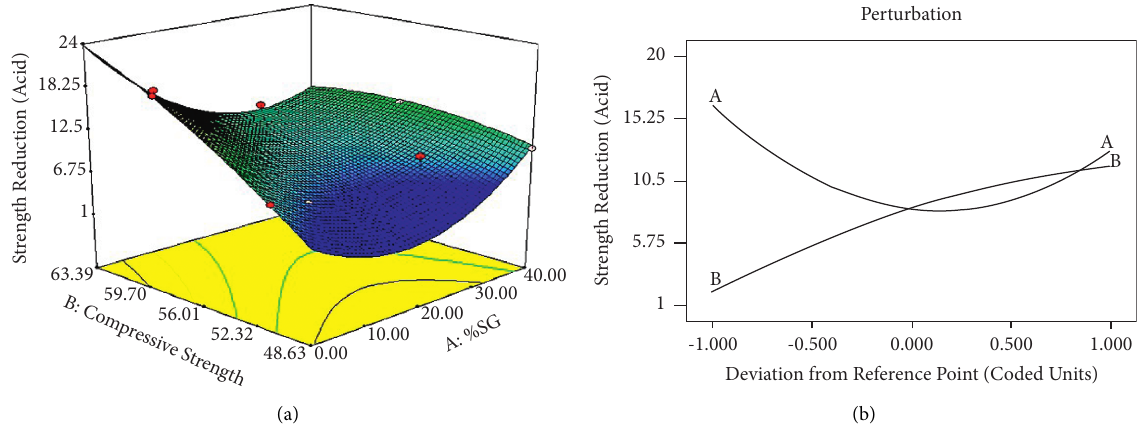
Figure 26: Response surface plots (a) and perturbation plots (b) indicating the relationship between spent garnet content and strength reduction with respect to strength reduction (acid resistance).